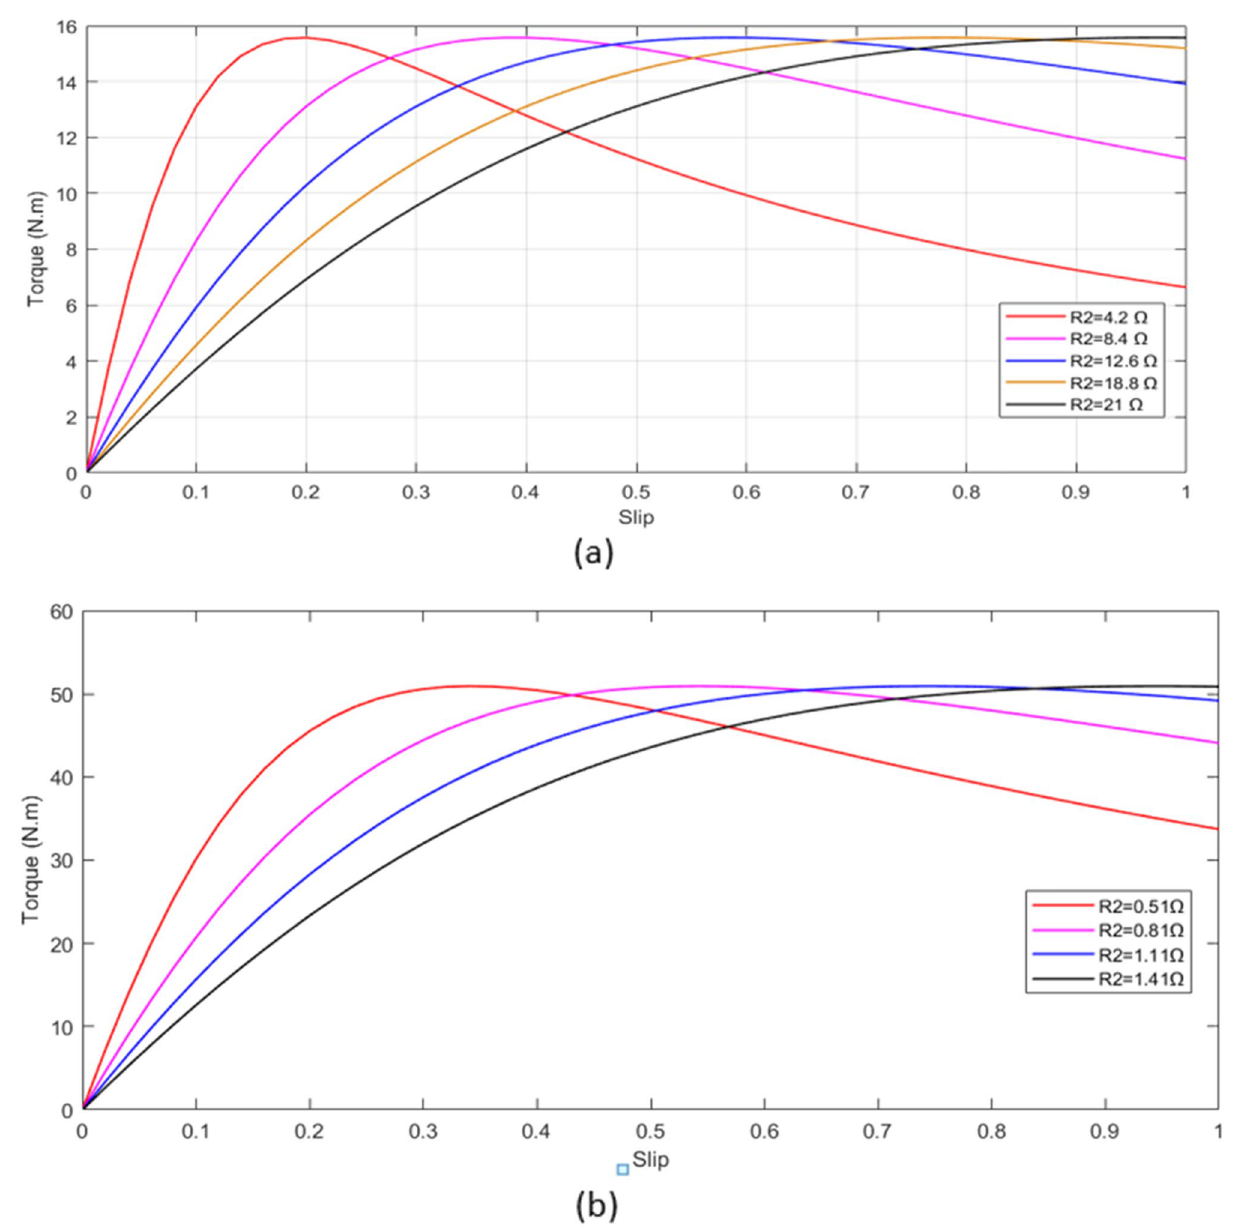
Fig. 10 Torque-speed characteristics at different rotor resistance of a M1, b